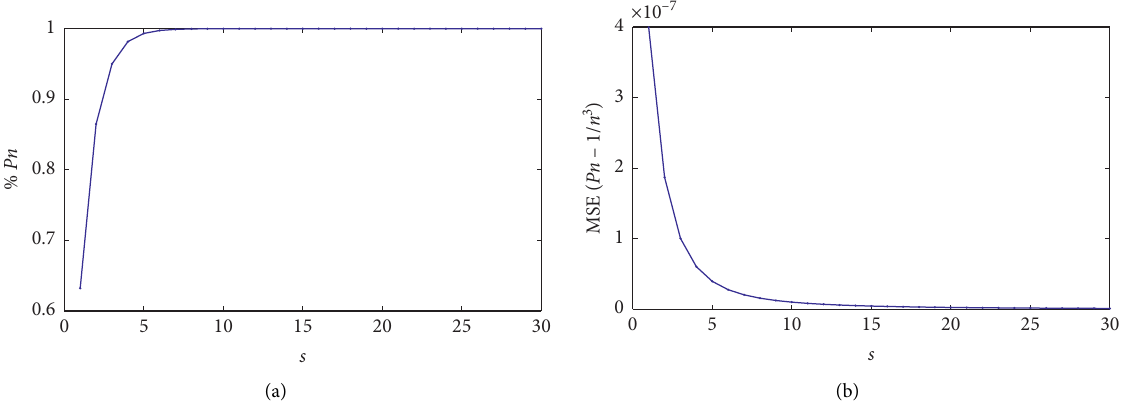
Figure 5: The results of P 􏽢 n and MSE, where n � 100, 􏽢 n � s × n 3 , and s � 1 , 2 , ... , 30. (a) The proportion of P 􏽢 n ; (b) the mean square error − 1/ n 3 ) . MSE ( P 􏽢 n